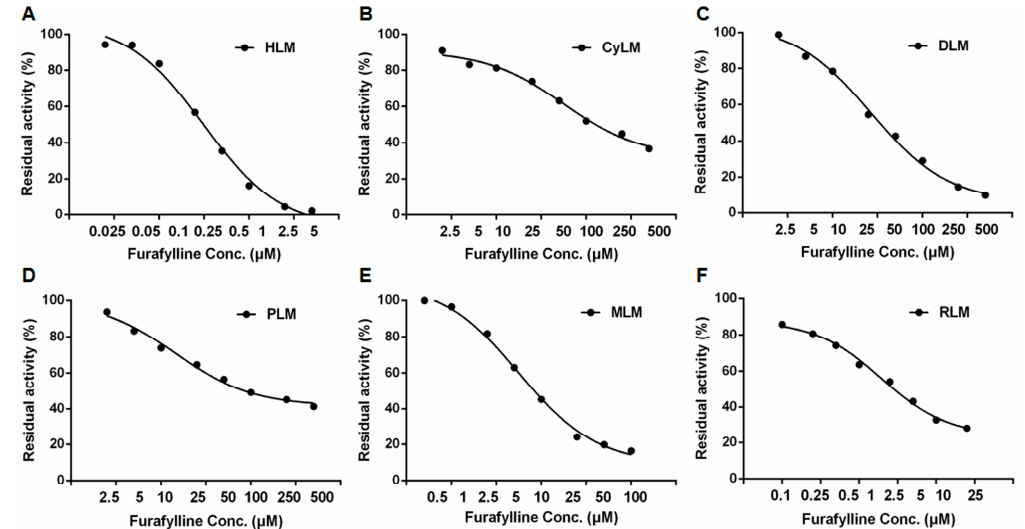
Figure 4. The dose-dependent inhibition curves of furafylline on NCMN -O- demethylation in liver microsomes from human ( A ), cynomolgus monkey ( B ), beagle dog ( C ), minipig ( D ), mouse ( E ) and rat ( F ). Table 1. The IC 50 values of furafylline against NCMN -O- demethylation in liver microsomes from different species.